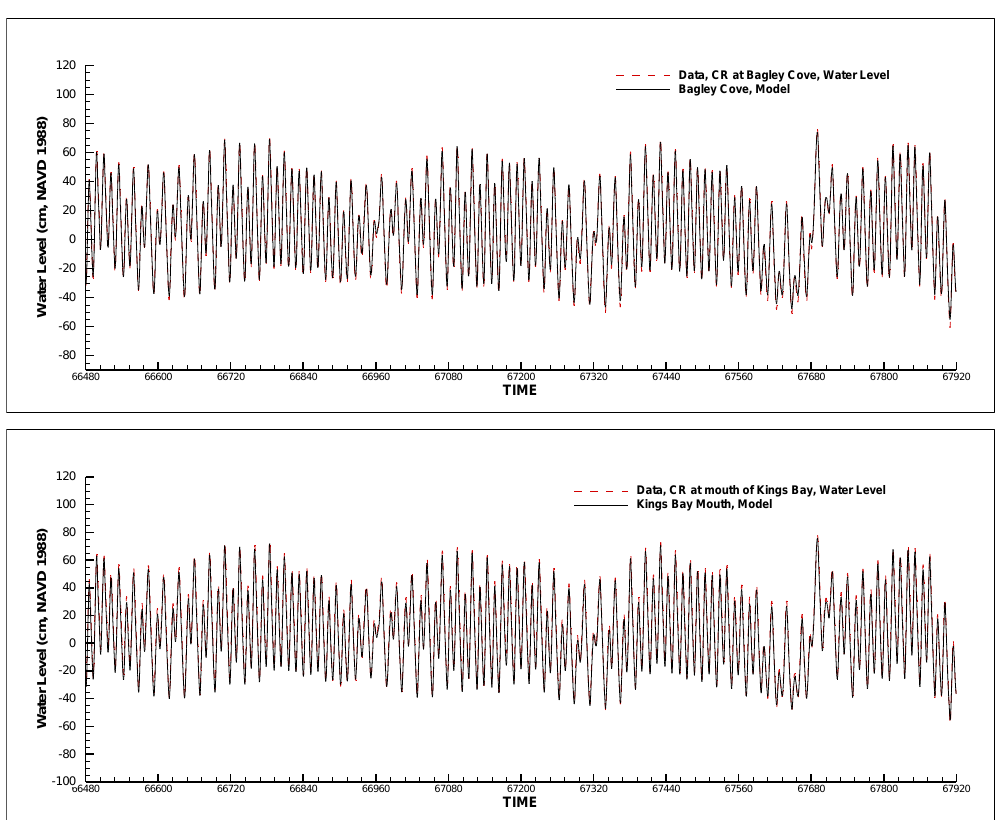
Figure 7. Comparison of measured and simulated water levels at the Bagley Cove station (top panel) and the mouth of King Bay station (bottom panel) during 2 August–1 October